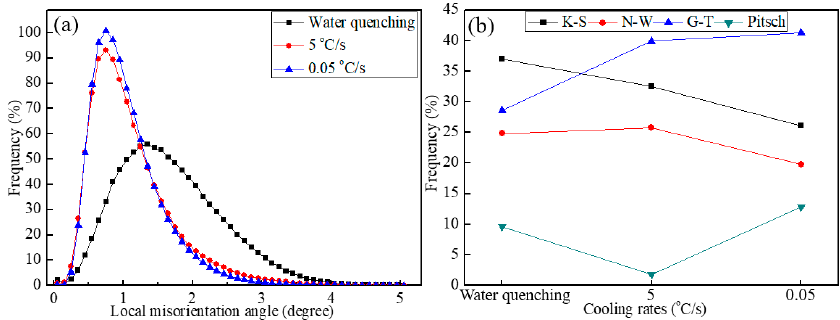
Figure 5. ( a ) Local misorientation distribution in three specimens; ( b ) function of the cooling rates for potential orientation relationships.